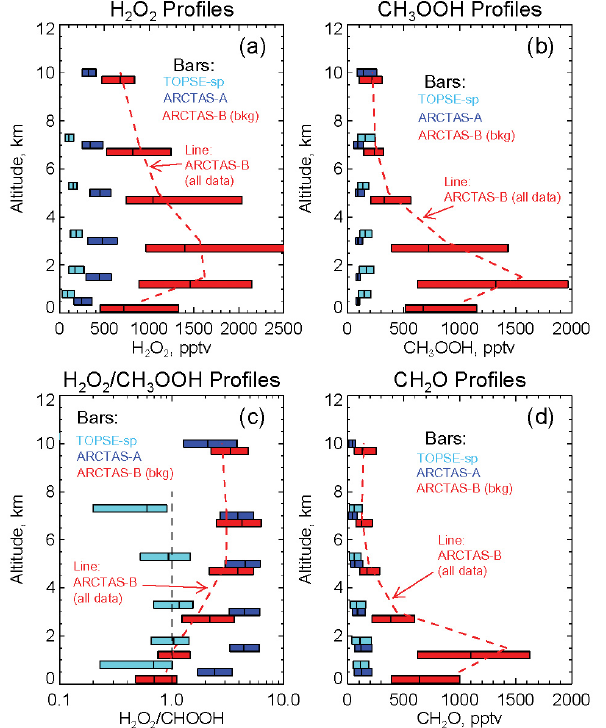
Fig. 5. Profiles of (a) H 2 O 2 , (b) CH 3 OOH, (c) H 2 O 2 /CH 3 OOH, and (d) CH 2 O during ARCTAS-A and -B and during TOPSE-sp. Bar plots and dashed lines are as described in Fig. 3.